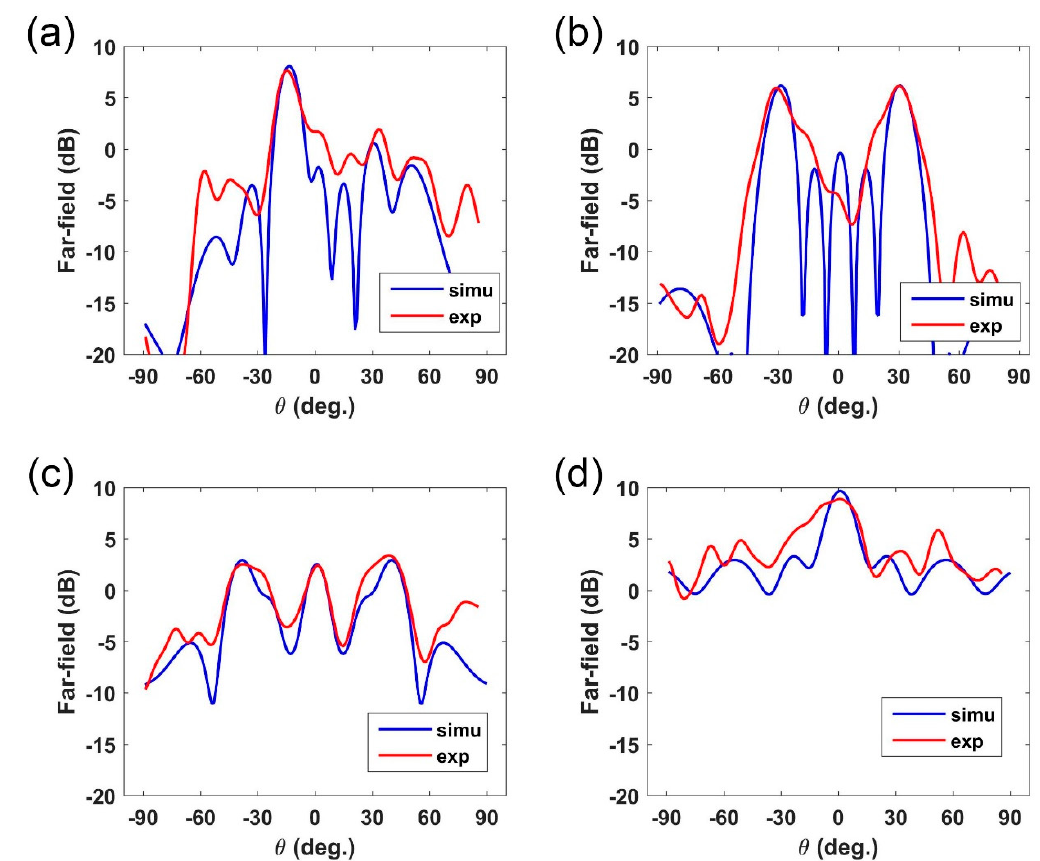
Figure 5. The measured far-field results for the designed four-phase distributions, as well as the related simulation data for comparison. ( a – c ) The measured far-field results for plane-wave incidence to realize one-beam, dual-beam, and three-beam. ( d ) The single beam reflection under antenna excitation.